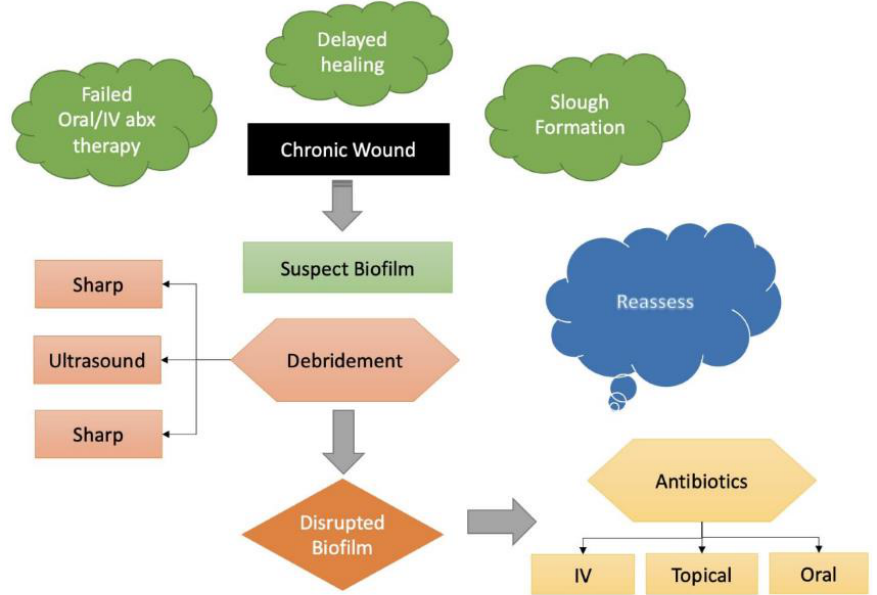
Figure 2. Biofilm Treatment Algorithm. Once a biofilm is suspected, debridement should be per- formed to disrupt the biofilm and improve the utility of post-debridement antibiotics. A less invasive alternative to sharp debridement could be